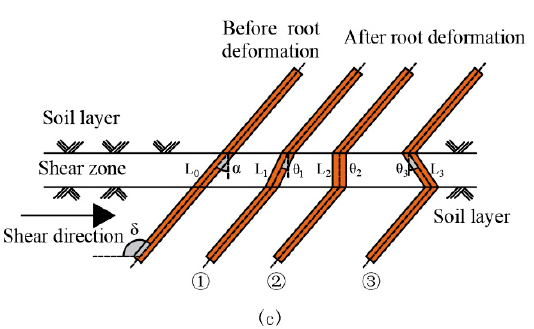
Figure 20. Relative orientation of roots and shear surfaces outside the applicable scope of the model ( a ) The root was parallel to the shear surface; ( b ) The roots didn’t pass through the soil shear surface; ( c ) The angle between root and shear direction δ > 90 ◦ , and the deformation pattern of roots was difficult to identify during shear.